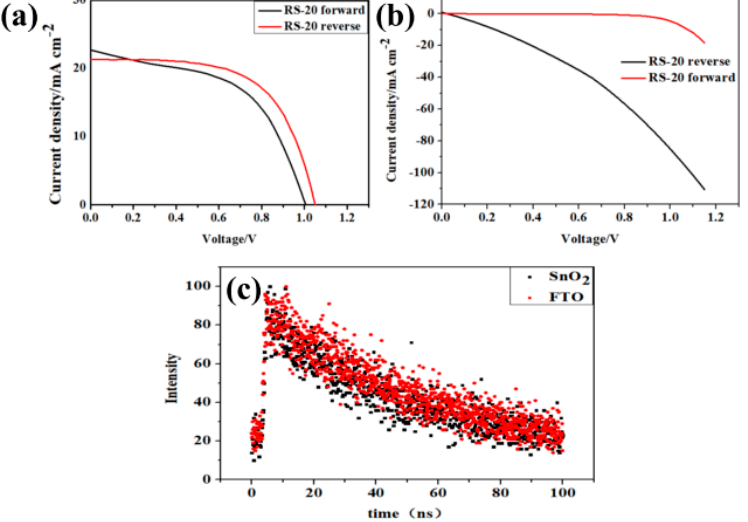
Figure 7. ( a ) Forward and reverse bias J – V characteristics of the RS–20; ( b ) J – V characteristics of the RS–20 under dark illumination; ( c ) Time resolved photoluminescence (TRPL) curve of the FTO substrate and the sputtered tin oxide substrate.